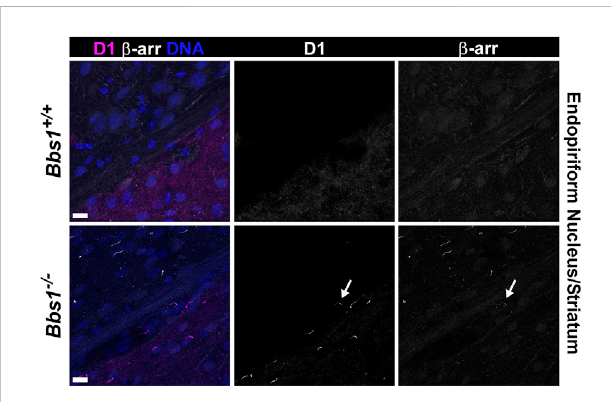
FIGURE 7 β -arrestin rarely accumulates in D1-positive cilia in the brains of Bbs1 − / − mice. Representative images of the junction of the striatum (lower right corner) and the endopiriform nucleus (upper left corner) in adult Bbs1 +/+ (upper row) and Bbs1 − / − (lower row) mice colabeled for D1 (magenta) and β -arrestin ( β -arr; white). The striatum is distinguished by the presence of D1 labeling and the endopiriform nucleusisdistinguishedbyalackofD1labeling.NotethelackofD1-or β - arrestin-positive cilia in the Bbs1 +/+ section but the presence of D1- positive cilia in the striatum and β -arrestin-positive cilia in the endopiriform nucleus of the Bbs1 − / − section (left panels). A single cilium (indicated by an arrow) is positive for both D1 and β -arrestin (middle and right panel). β -arrestin colocalized to 0.9% (2/214; n = 3 animals) of D1- positive cilia in Bbs1 − / − sections. Nuclei are stained with DRAQ5 (blue). Scale bars represent 10